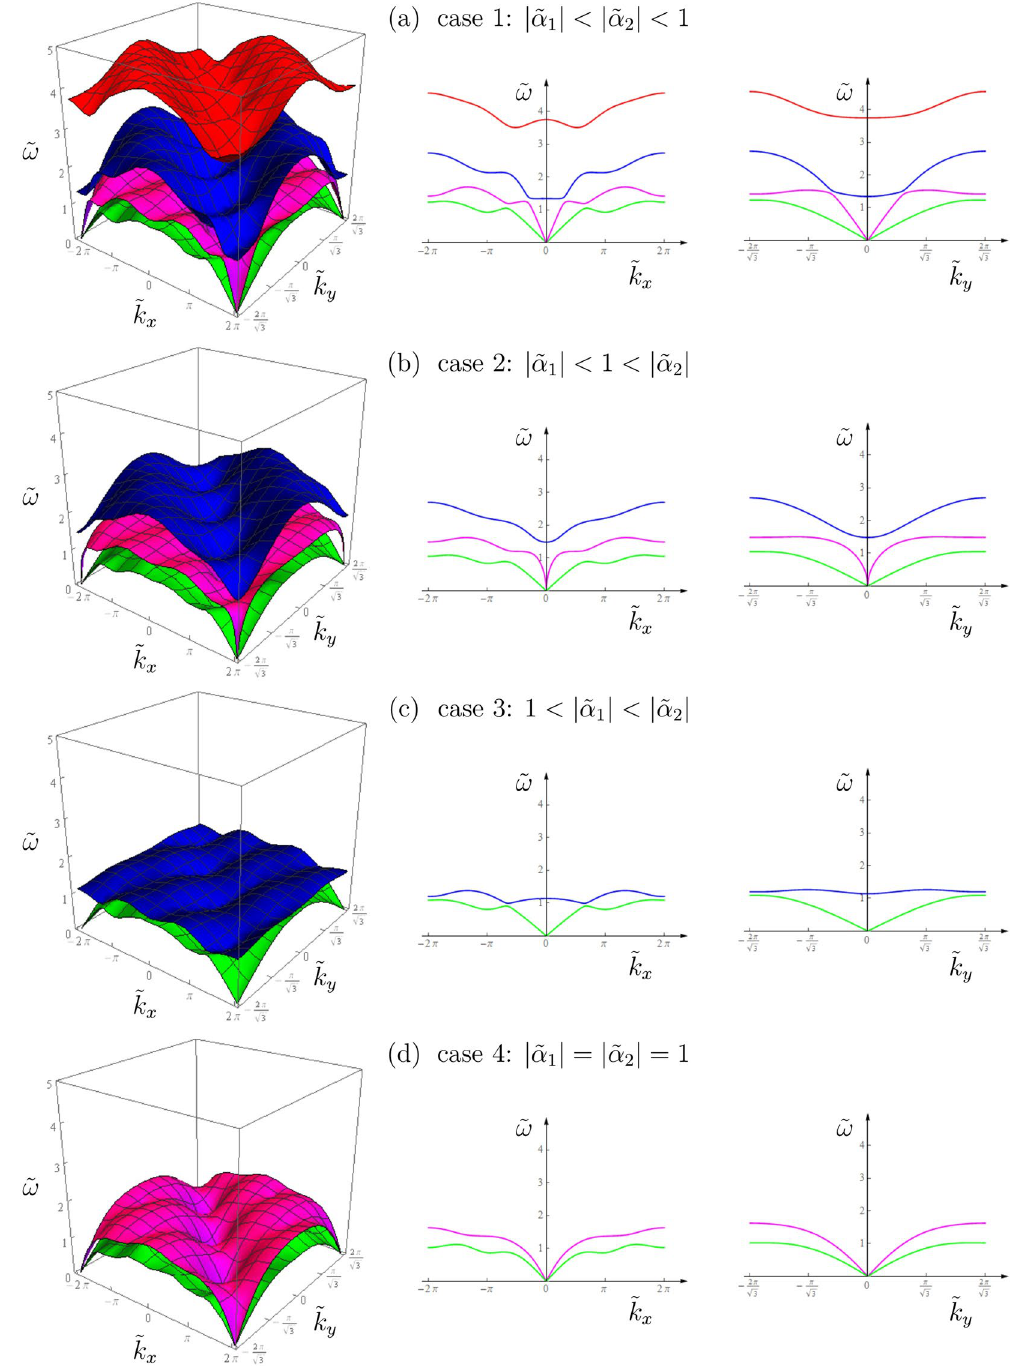
Figure 3. Dispersion surfaces (left) and relative cross-sections for =  k 0 following values of the spinner constants: ( a ) α α = . = .   0